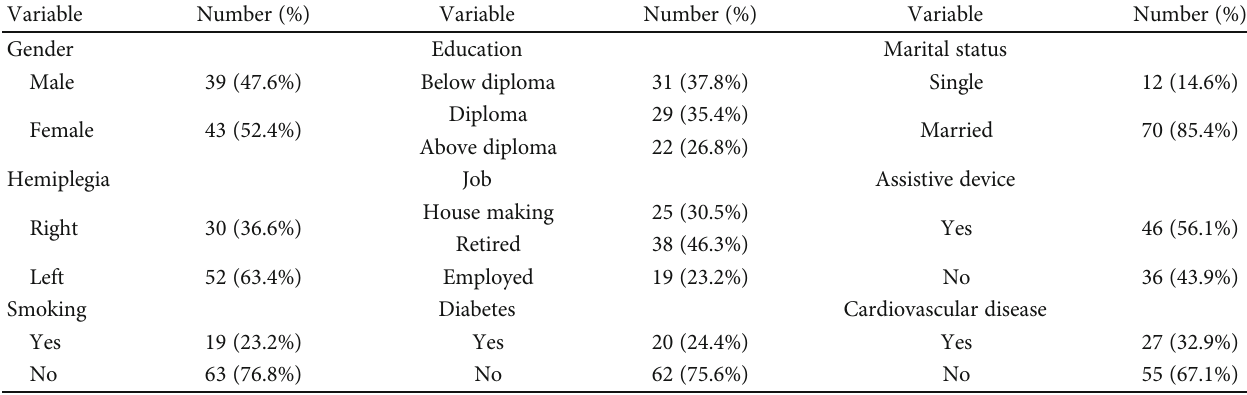
Table 1: Descriptive information about the demographic and clinical characteristics of participants.